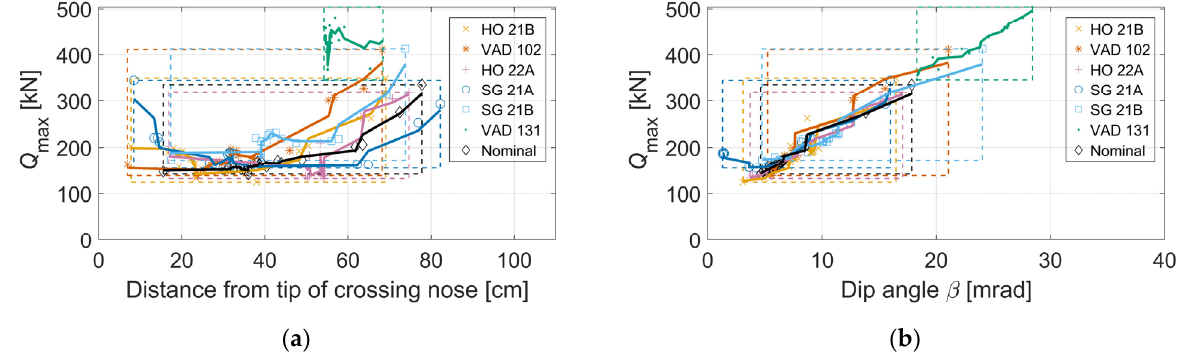
Figure 14. Correlation between Q max on the crossing rail for the leading wheel and ( a ) longitudinal position of wheel transition relative to the tip of the crossing nose, ( b ) dip angle. Simulations are computed for seven crossing panels, 19 different wheel profiles, and a train speed of 160 km/h. Each scatter point presents the result for a particular wheel profile, while the marker makes a relation to the corresponding crossing panel. Continuous lines present results after the application of a three-point moving average filter for the cloud of the scatter points. Dashed boxes (with the corresponding color) cover the min-max domain of results for each crossing panel. The Q max values are taken from results that are low-pass-filtered at 250 Hz.